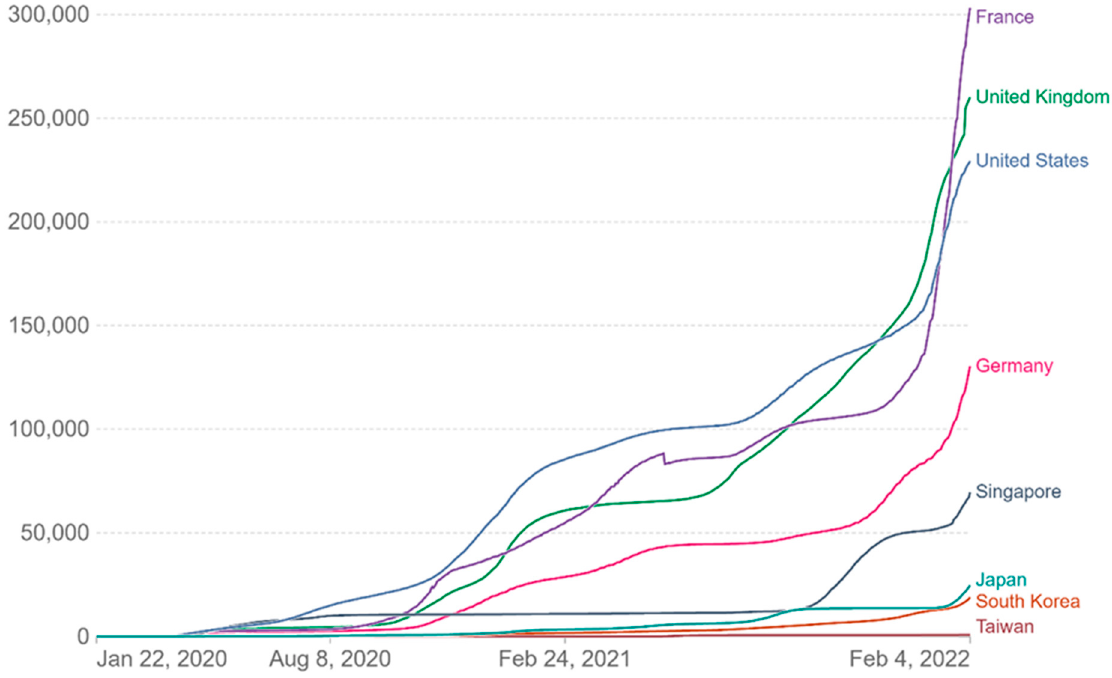
Figure 1. Daily new confirmed COVID-19 cases in developed and middle power countries (per million people). Source: Data from Johns Hopkins University CSSE COVID-19 Data via Our World in Data (https://ourworldindata.org (accessed on 9 January 2022)) 2 .